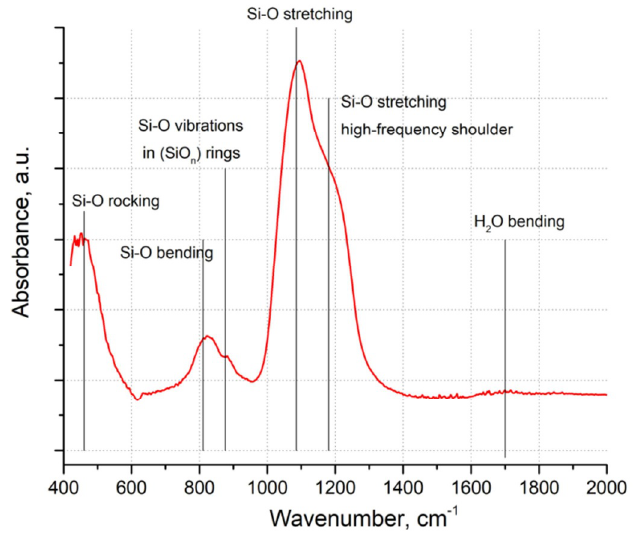
Fig. 3. FTIR spectrum for silica nanostructures grown on the indium catalyst at a temperature of